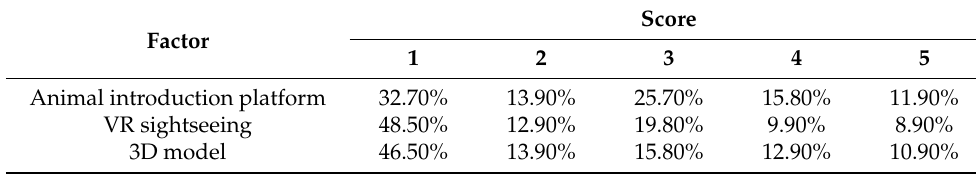
Table 11. Results (Performance) of the second-level questionnaire (Tokyo Zoonet